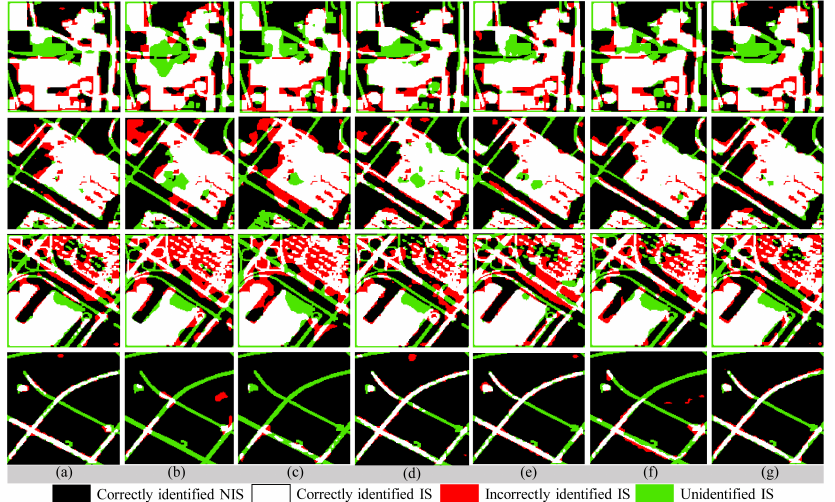
Figure 11. Impervious surface extraction results based on HRNet with various features. ( a – g )